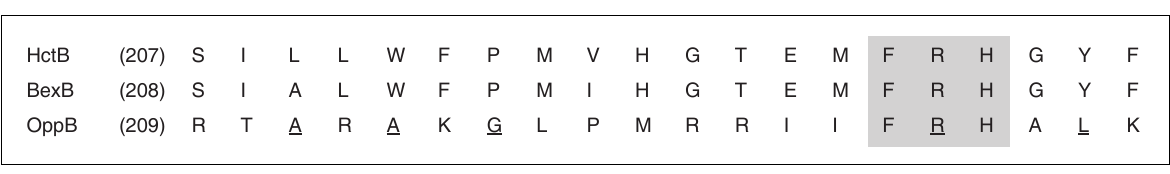
FIG. 6 Alignment of the relatively hydrophilic portions of HctB, BexB and OppB. The number in brackets is the position of the first amino acid in each sequence. Identical amino acids in all three genes are boxed, and the matches of the OppB sequence to the Dassa/Hofnung consensus are underlined TABLE 2 Comparison of capsular transport gene and protein sizes and % identity and similarity between proteins from H. para- gallinarum 1742 with those of related bacterial species H. paragallinarum Related bacterial species Comparison on protein